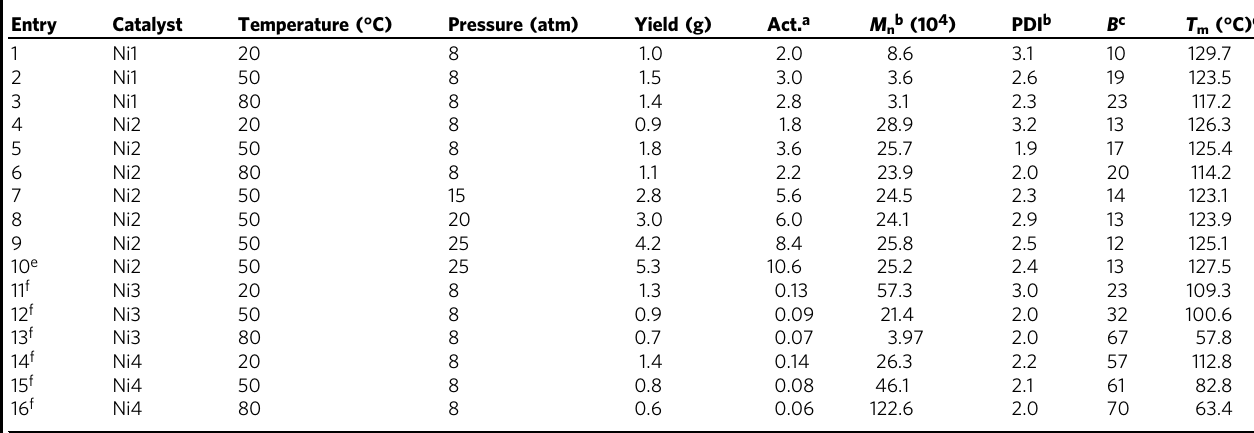
Polymerization conditions: catalyst = 1 μ mol; toluene = 28mL, CH 2 Cl 2 = 2mL, time = 3min a The yields and activities are averages of at least two runs. The unit for activity is de fi ned as 10 7 gmol − 1 h − 1 b Determined by GPC in trichlorobenzene at 150°C c B = branches per 1000 carbons, determined by 1 H NMR spectroscopy d Determined by differential scanning calorimetry (DSC) e Heptane = 28mL, CH 2 Cl 2 = 2mL f Time =